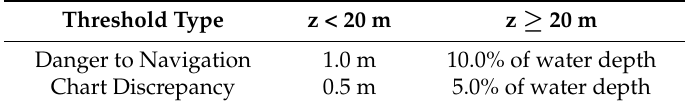
Figure 4. An example of dangers to navigation (DtoN) detection. In the pane ( a ), a 10.1-m survey sounding (in blue) is surrounded by two charted soundings (in black) and two depth contours of 10 m and 20 m. The pane ( b ) shows the result of the triangulation (dashed lines in magenta) and a DtoN candidate (grey circle with a cross symbol. The latter has a vertical distance of approximately 5 m (red value overlaying the circle) from the underlying tilted triangle. Table 2. Default threshold values adopted by the algorithm to identify the DtoN candidates and potential chart discrepancies. For depth values less than 20 m, the adopted threshold follows best practices defined in the NOAA Office of Coast Survey (OCS) Hydrographic Surveys Specifications and Deliverables (HSSD) manual [42]. Deeper waters have a much less compelling safety-of-navigation requirement; thus, the chosen percentages of water depth were selected after having considered the required International Hydrographic Organization (IHO) standard requirements for the original survey data. Adopting cartographic agencies should modify such values based on their adopted best practices.